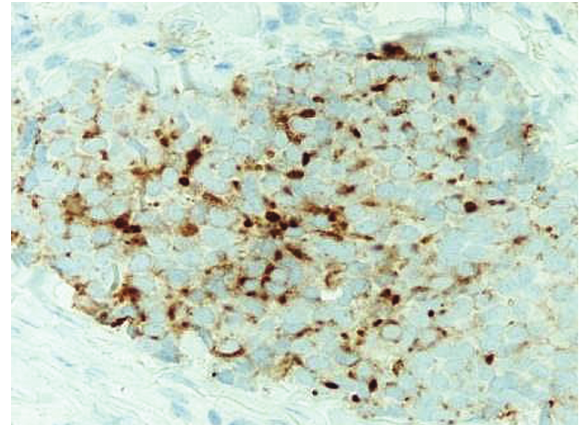
Figure 5: The tumor cells are positive for chromogranin.